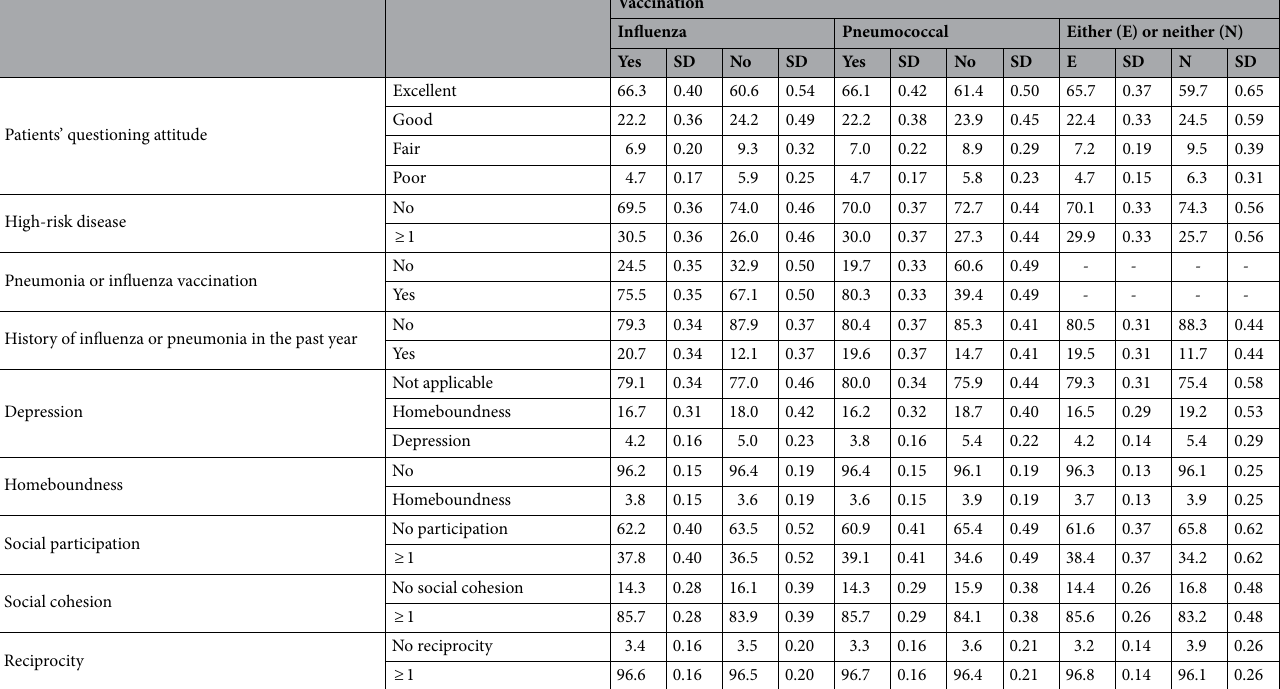
Table 1. Variables of participants by the status of influenza or pneumococcal vaccinations. IADL instrumental activity of daily life, IA intellectual activity, SR social role, TMIG-IC Tokyo Metropolitan Institute of